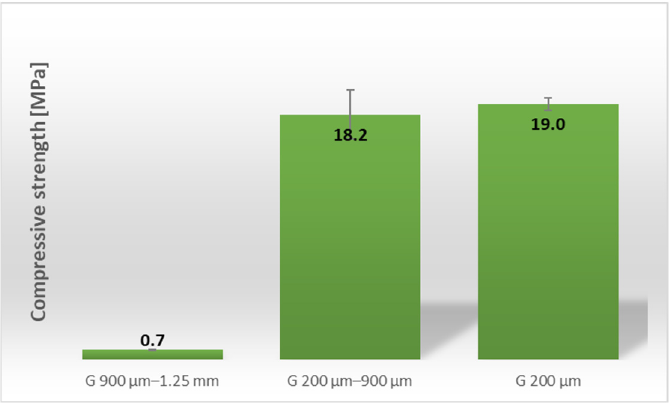
Figure 2. Results from the compressive strength test.